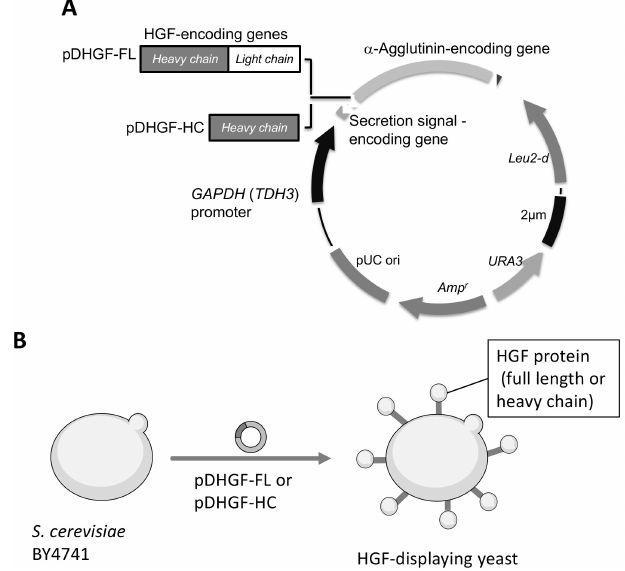
Figure 1. Plasmid constructs for HGF display on the yeast cell surface. ( A ) Genetic fusion of HGF and α -agglutinin. Leu2-d in the plasmid is inserted for a multiple copy in the yeast cell. ( B ) Schematics of HGF production on the yeast cell surface. HGF, hepatocyte growth factor.